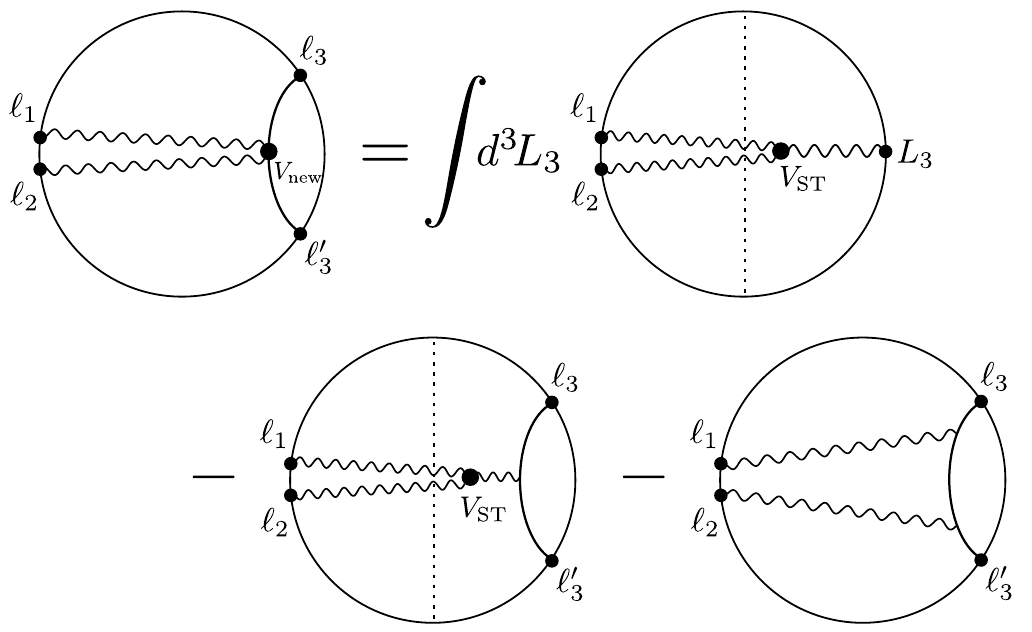
Figure 7 . The main step in the radial locality argument. The V new,TT diagram is expressed as a combination of terms that are manifestly analytic at ‘